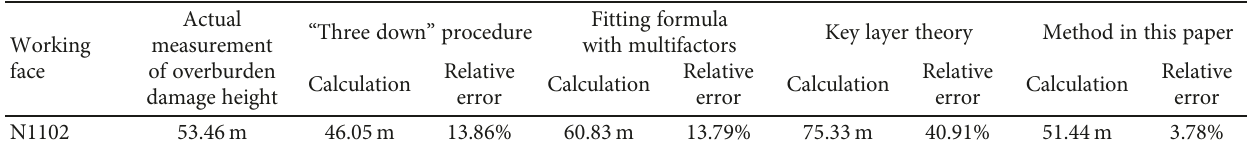
Table 8: Overlying stratum damage height calculation accuracy by 4 methods.